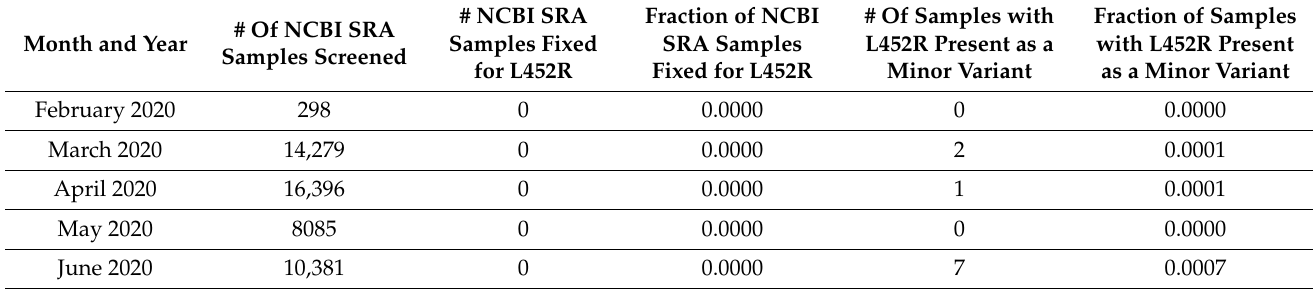
Table 2. Number of samples containing the Spike L452R change present as a fixed variant or minor variant in NCBI SRA samples across each month as identified by iSKIM. Numbers in bold represent the month where a high frequency of samples with the L452R change was identified prior to emergence first in the Epsilon